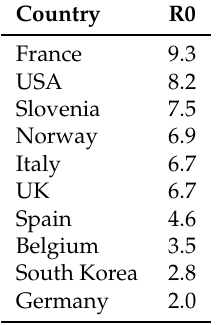
Table 1. Basic Reproductive Number calculated for some studied